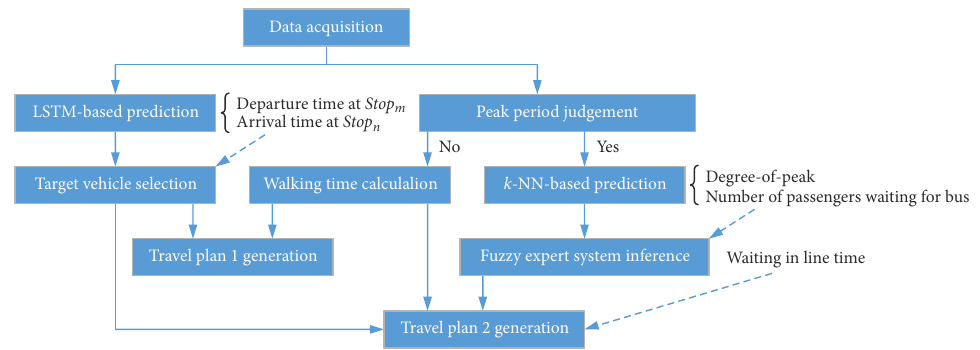
Figure 2. Flow diagram of the IBTSM